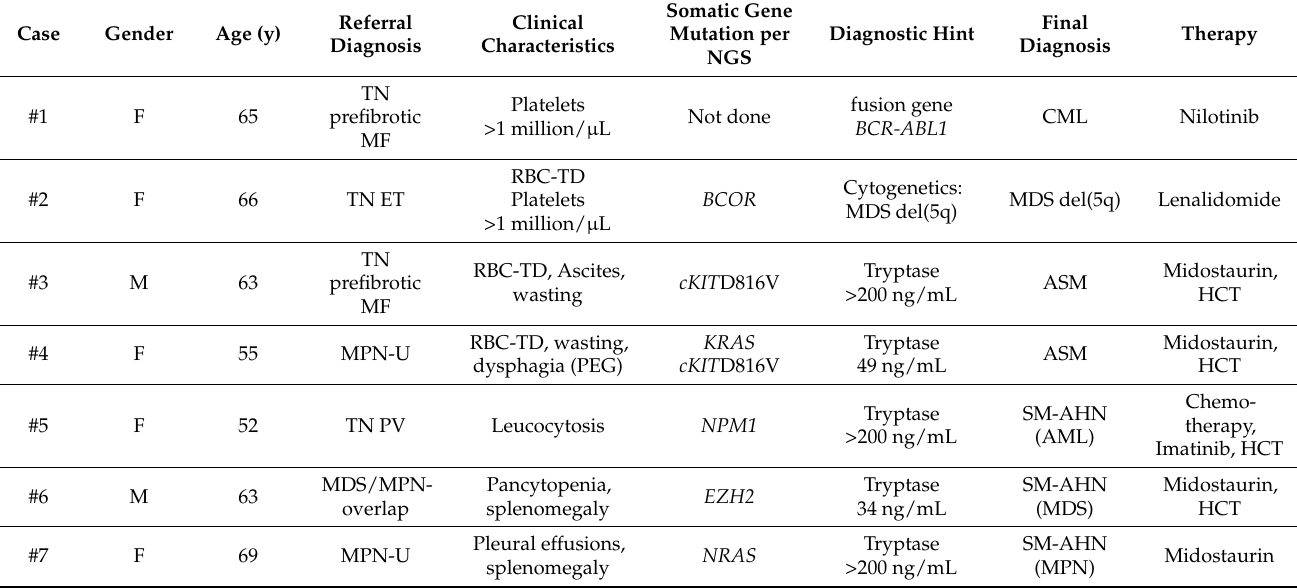
Table 1. Patients, initial referral diagnosis, diagnostic clue, final diagnosis, and